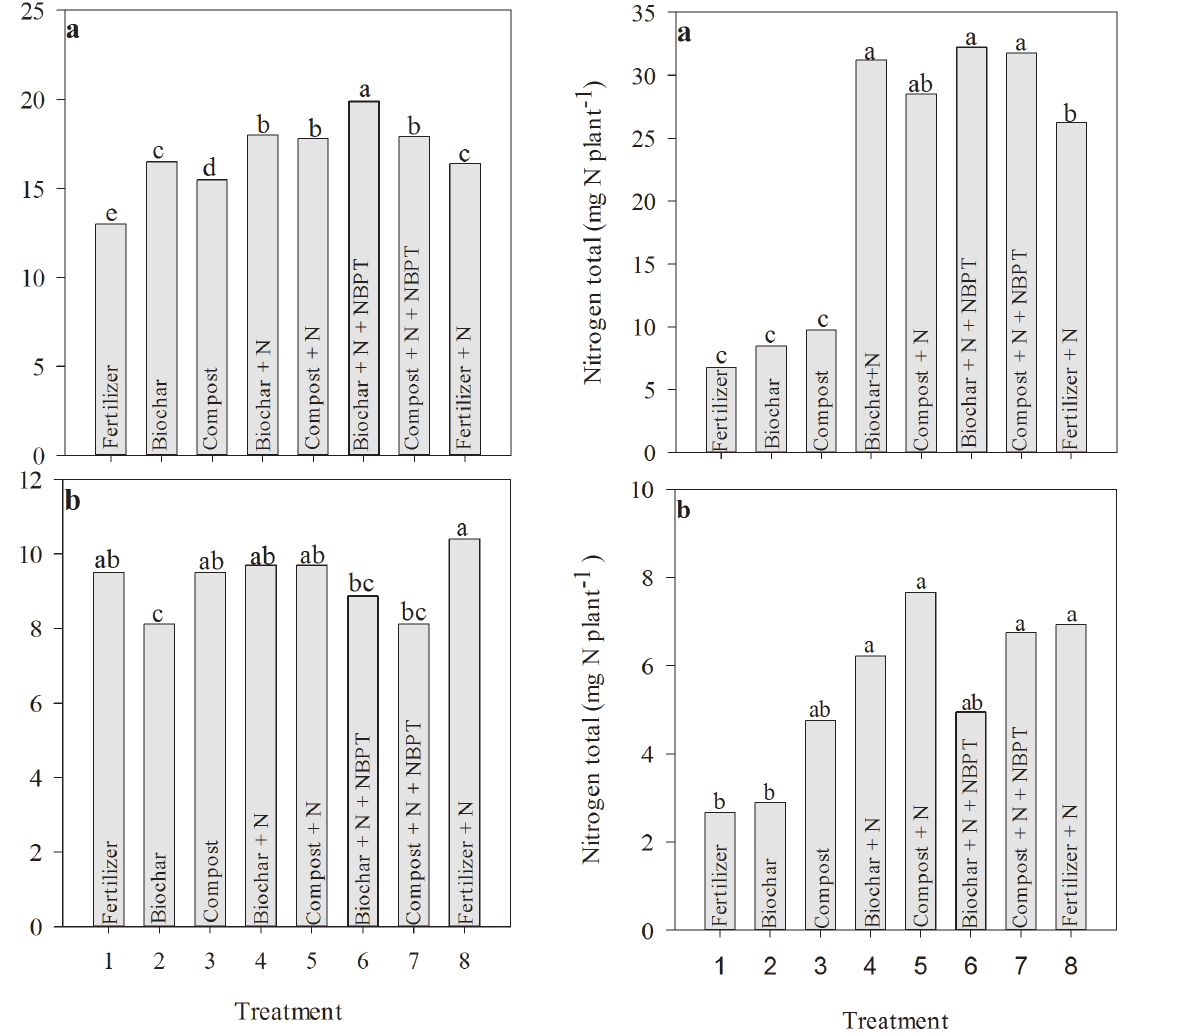
Figure 1 - Nitrogen concentration in shoots ( a ) and roots ( b ) in response to the addition of compost and biochar combined with N and urease inhibitor: 1- Fertilizer; 2- Biochar; 3- Compost; 4- Biochar + N; 5- Compost + N; 6- Biochar + N + NBPT; 7- Compost + N + NBPT; and 8- Fertilizer + N. Treatments followed by similar letters do not differ by Tukey’s test at the 5% significance level.